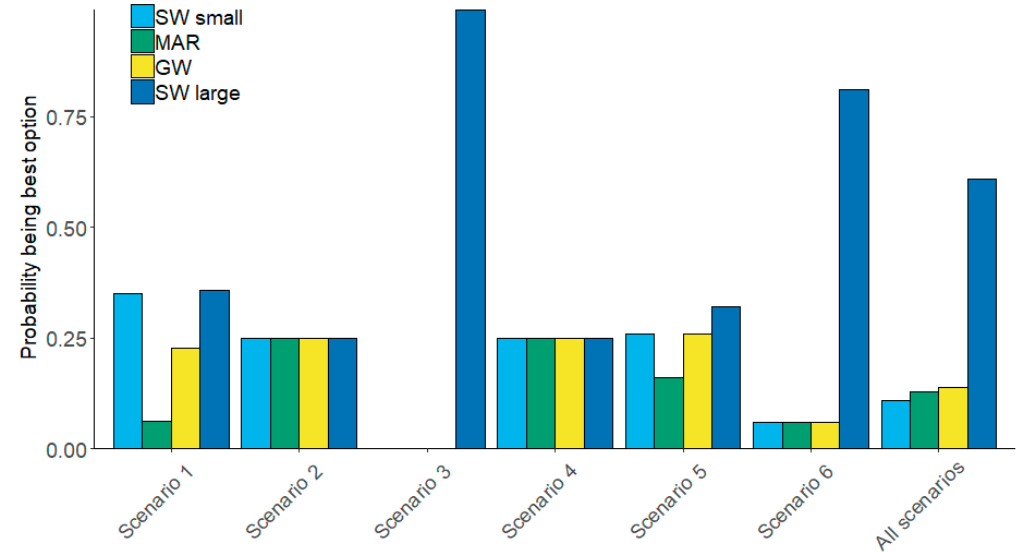
Figure 4. Probability that each measure is the best option with respect to risk reduction.